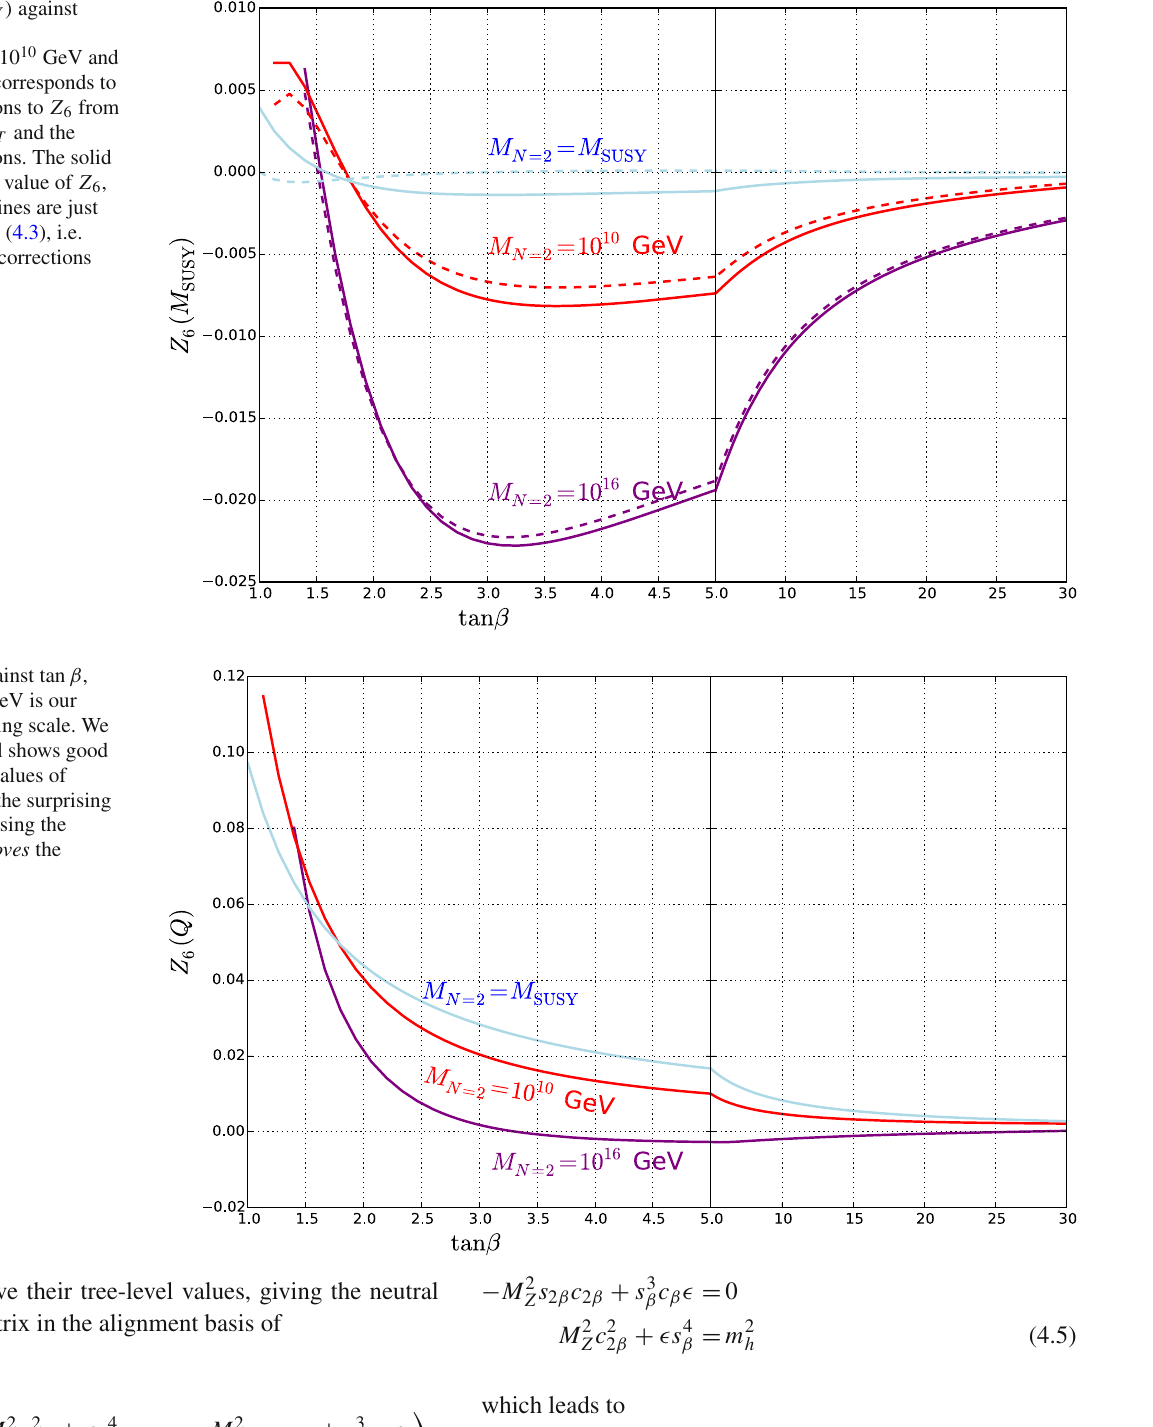
Fig. 4 Z 6 ( Q ) against tan β , where Q = 400 GeV is our low-energy matching scale. We find that the model shows good alignment for all values of tan β > 1 . 5, with the surprising conclusion that raising the N = 2 scale improves the